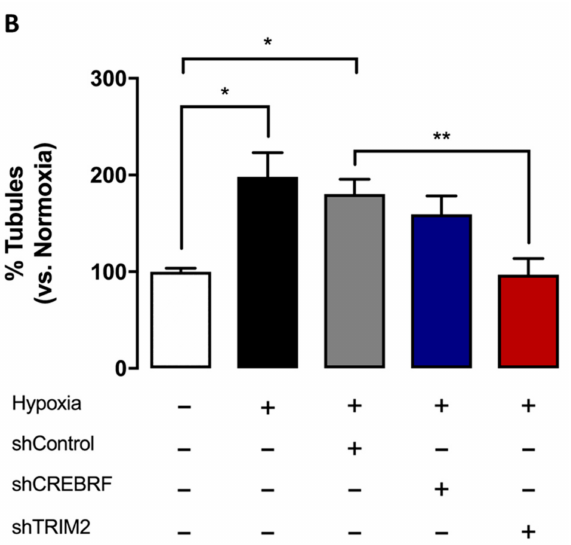
Figure 4. Tubulogenesis under hypoxic conditions in HCAECs transduced with lentivirus containing shRNA against a control sequence (shControl), CREBRF (shCREBRF) or TRIM2 (shTRIM2) compared to non-transduced HCAECs under normoxic conditions. ( A ) Representative images of tubule formation were photographed under light microscopy. Scale bars, 50 µ m; ( B ) Number of tubules was counted and analyzed using ImageJ software. Results are mean ± SEM. * p < 0.05, ** p < 0.01 by unpaired two-tailed t